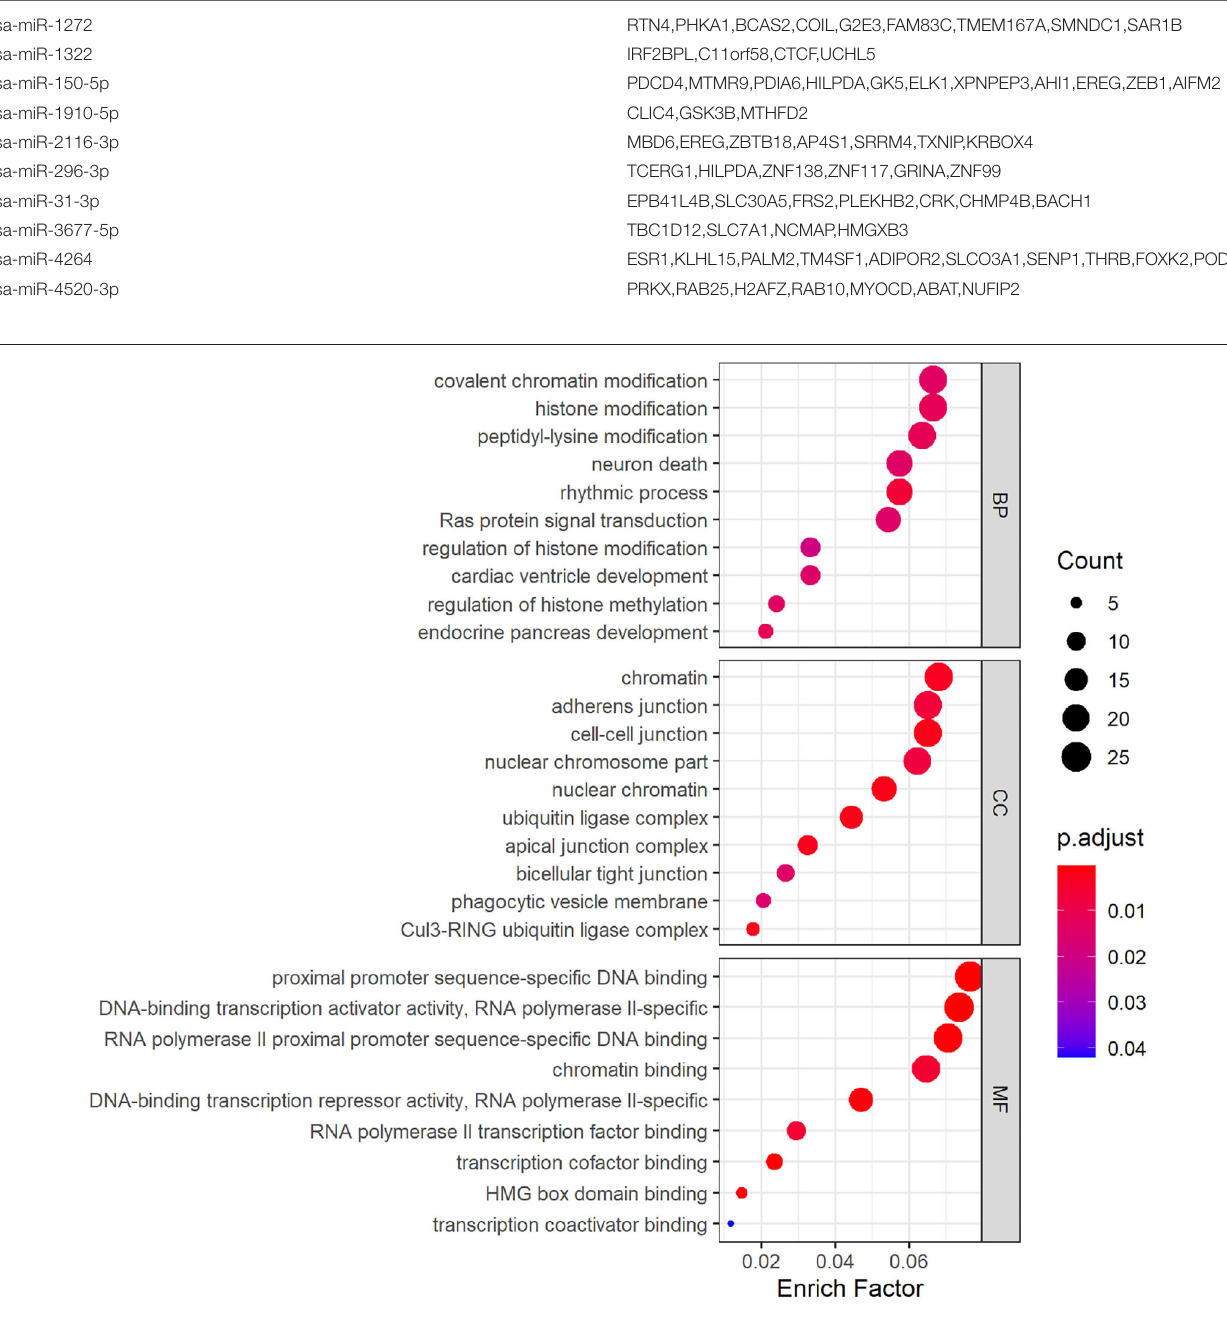
tissues or at developmental stages and most sequences are highly conserved (Wolf et al., 2017). Recently, with the development